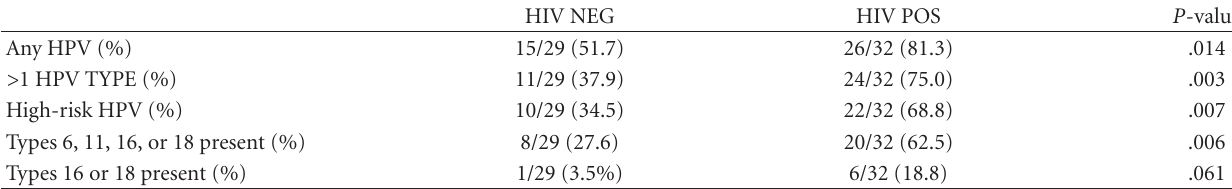
Table 2: Influence of HIV on HPV.